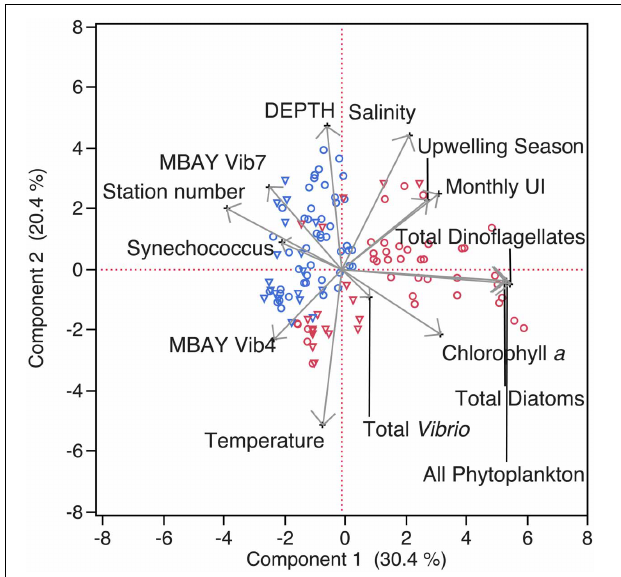
FIGURE 2 | Principal Component Analysis of physical and biological parameters. MBAY Vib4 ( O ) MBAY Vib7 ( (cid:2) ) from stations C1 (red) and M2